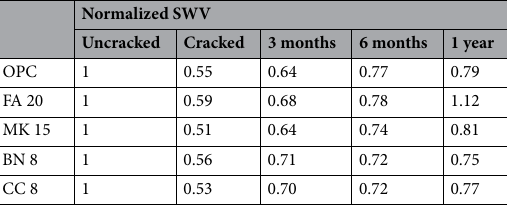
Table 4. Shear wave velocity evolution of mortar specimens submerged in water.